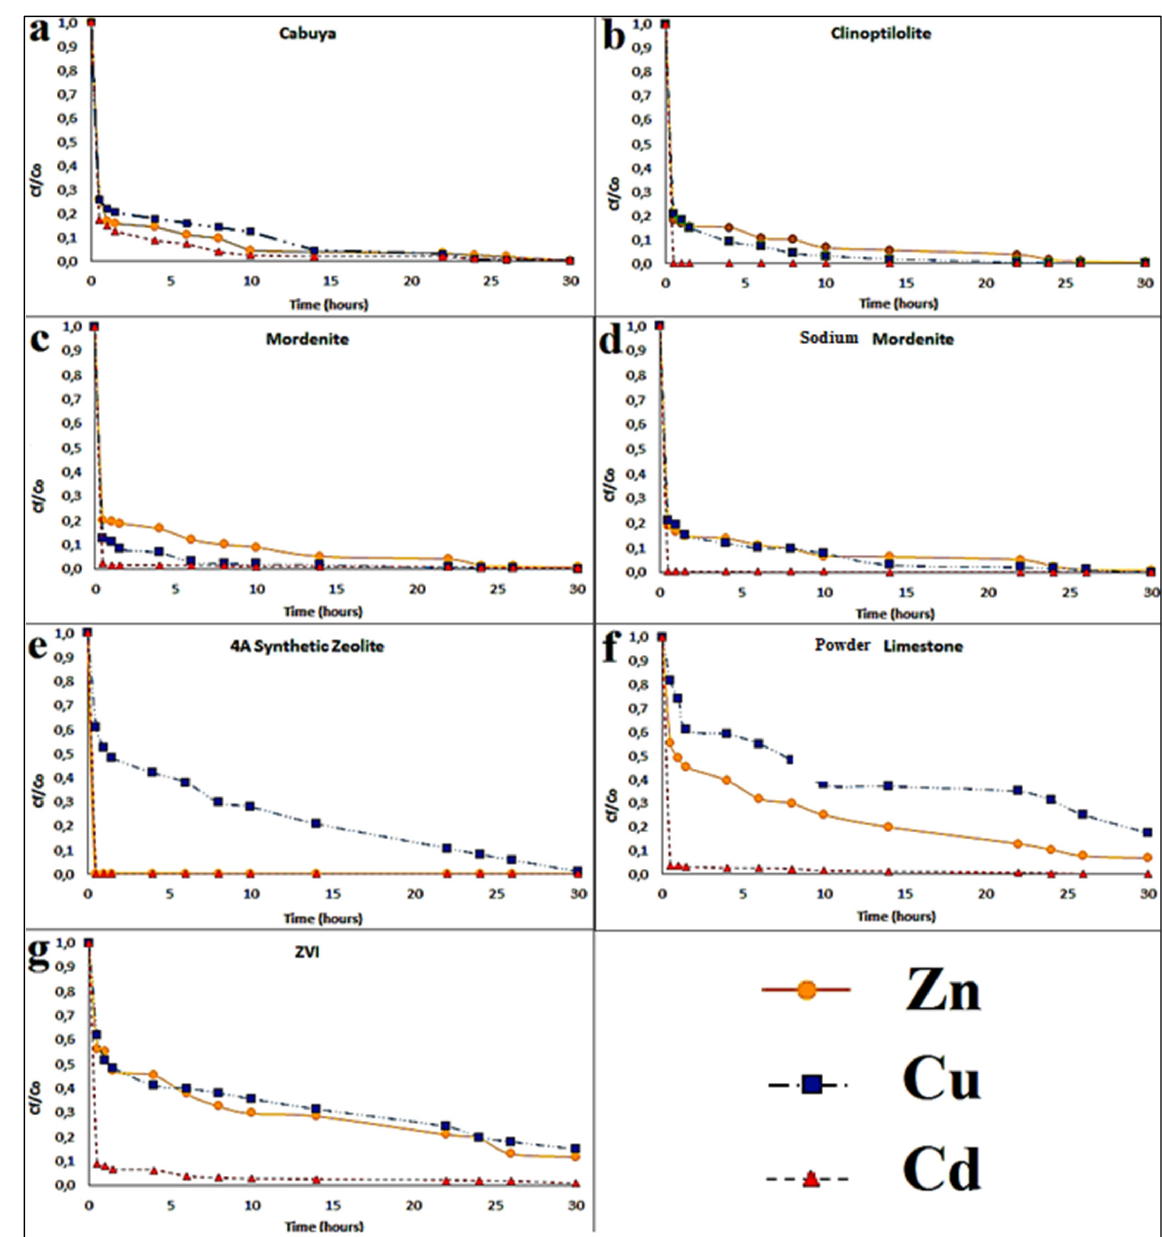
Figure 2. Concentration trends over time, for each reactive material and for all transition metals considered, resulting from the batch tests. The experimental conditions in ranges were: static fluid, temperature: 25–28 °C and pH: 7.1–8.8. Specifically: ( a ) for Cabuya; ( b ) for Clinoptilolite; ( c ) for Mordenite; ( d ) for Sodium Mordenite; ( e ) for 4A Sinthetic Zeolite; ( f ) Powder Limestone; ( g ) Zero Valent Iron (ZVI).